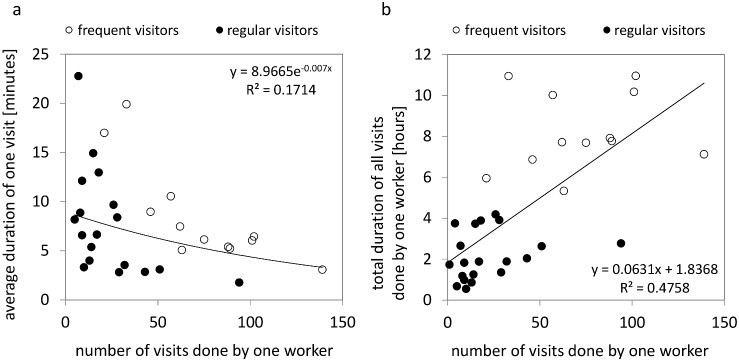
Duration of one visit and total duration of all hot spot visits for individual ant workers.(a) Relationship between the number of visits to the hot spot and the average duration of one visit, for individual ants. The regression line did not include the two outliers described in the text. (b) Relationship between the total number of visits to the hot spot and the total time spent sun basking (as cumulative duration of all visits), for individual ants. Line and equation for the exponential (a) and the linear regression (b) are provided; both are statistically significant at p<0.05.